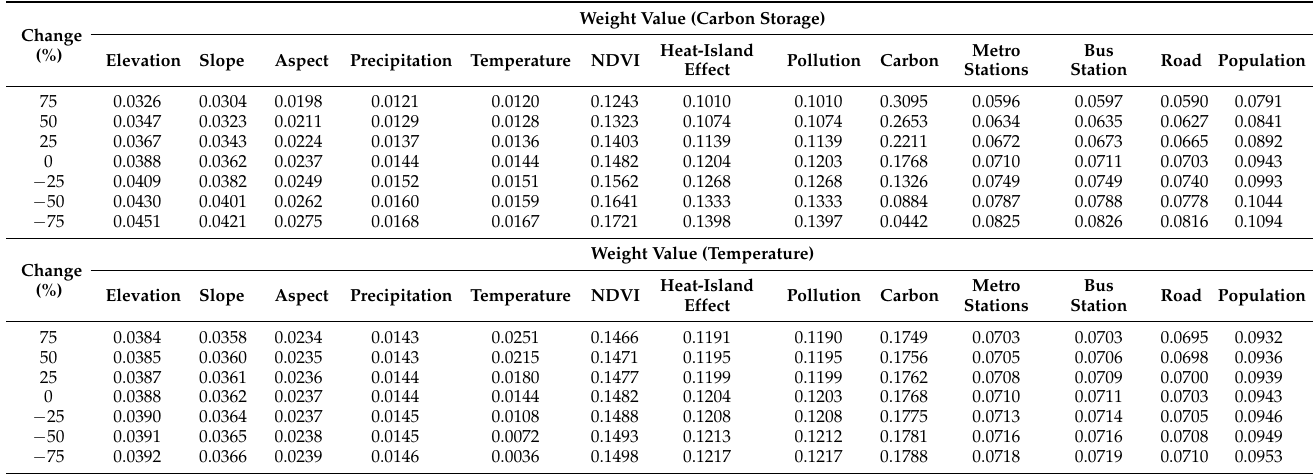
Table 5. Results on the variation of weight fluctuations of the ‘carbon storage’ and ‘temperature’ criteria for the siting analysis of urban parks.